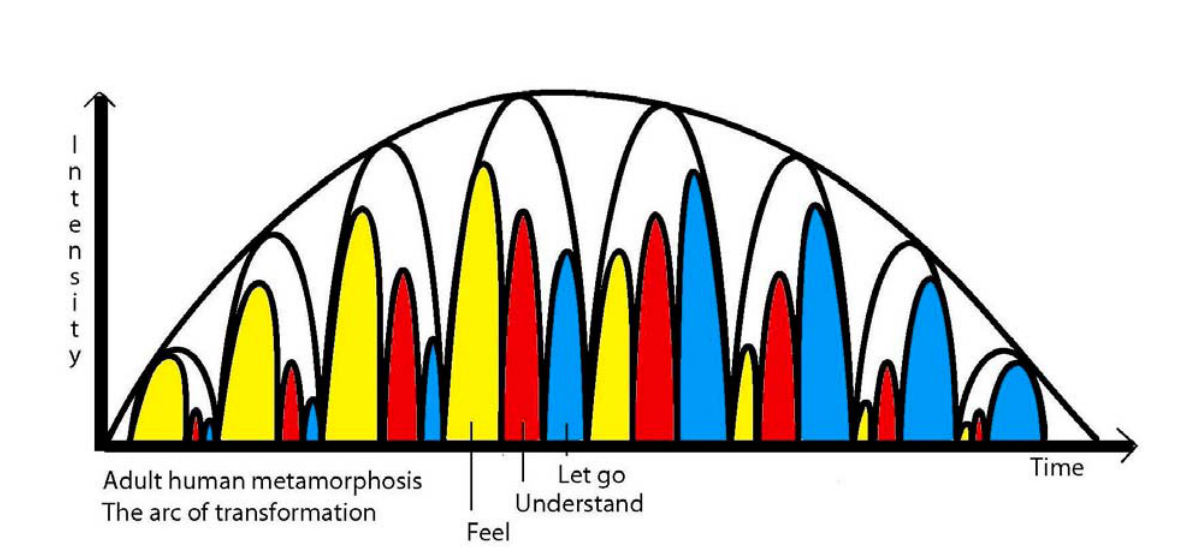
Figure 1: The arch of therapeutically transformation in clinical holistic medicine. There is three core elements of the therapeutic process: to feel (yellow), to understand (red), and to let go (blue) of negative, life-denying beliefs and attitudes. In the first sessions the emotional discharge dominates; as intensity in therapy grows, the element of understanding becomes more dominant, and in the end when the “heat” leaves therapy, cool understanding raises from the bottom of the patients soul